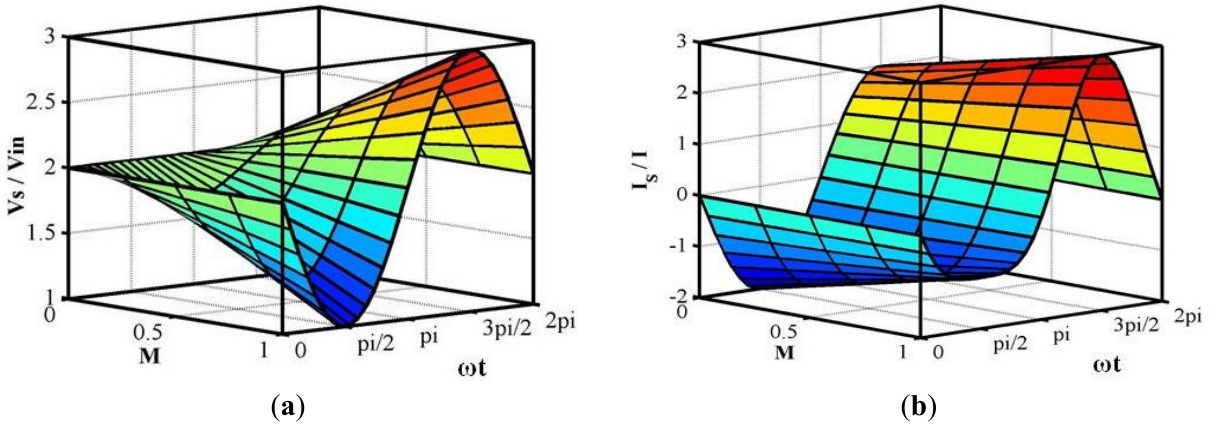
vs . M and ω t ; ( b ) Current through inductor 1